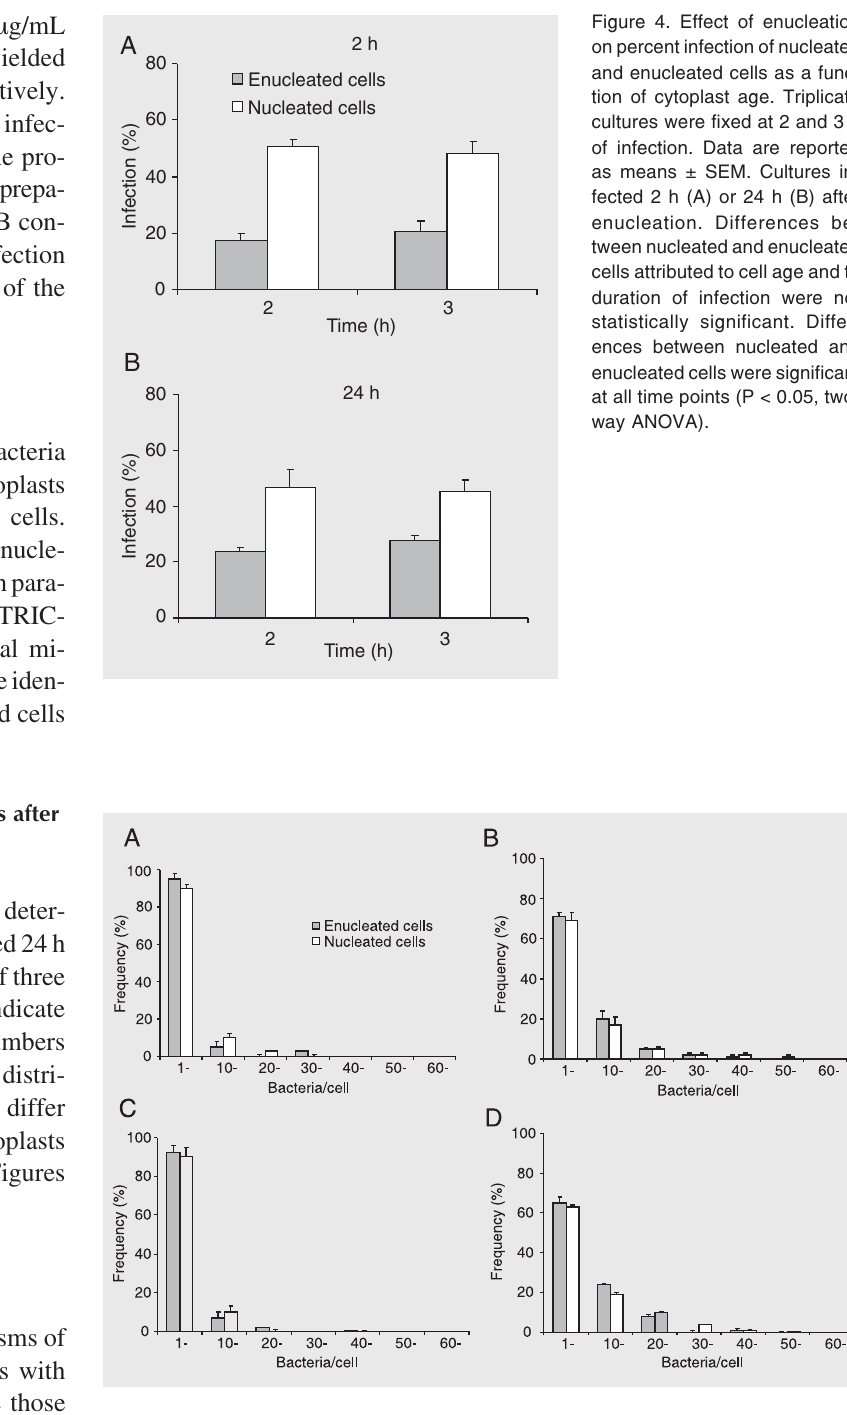
Figure 5. Frequency distributions of bacteria per cell. Same experiment as in Figure 4. Cultures infected 2 h after enucleation: 2-h infection (A), 3-h infection (B). Cultures infected 24 h after enucleation: 2-h infection (C), 3-h infection (D). Data are reported as means ± SEM. Differences between nucleated and enucleated cells attributed to cell age or to the duration of infection were not statistically significant (two-way